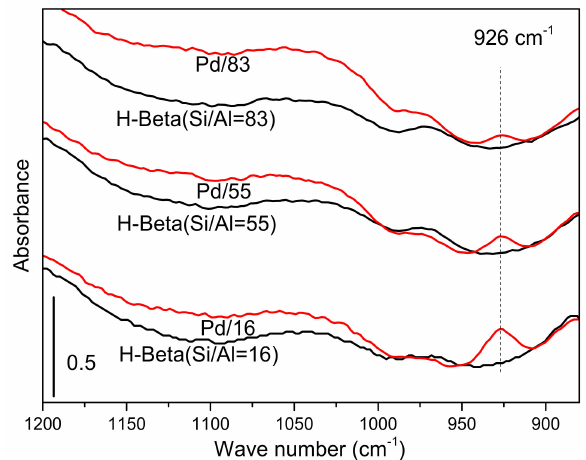
Figure 4. Ex-situ FT-IR of each sample (flow: N 2 ; temperature: 200 ◦ C).